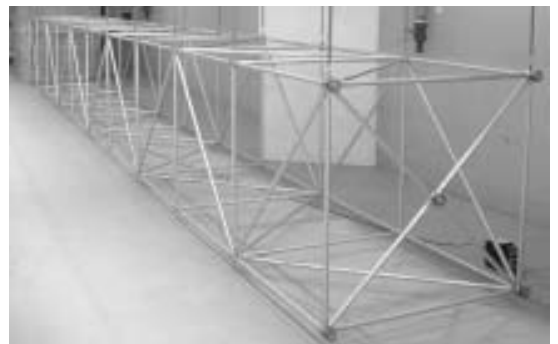
Fig. 1. Truss structure.